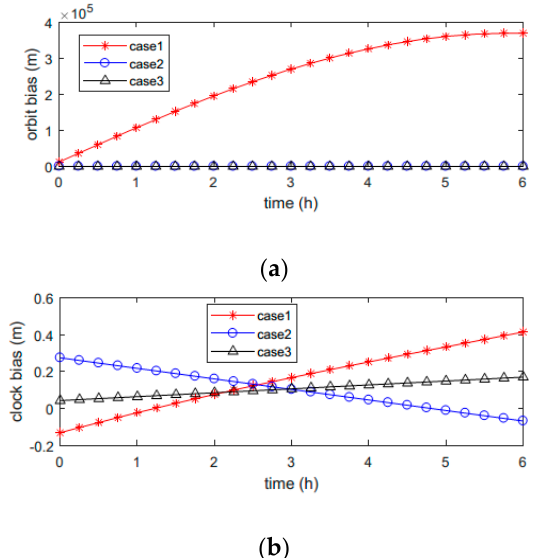
Figure 1. Orbit and clock biases between results calculated with ephemerides before and after the unhealthy state during the satellite unhealthy period. Different cases represent results calculated with different ephemerides. Case 1 represents a maneuvered satellite orbit and clock biases between results calculated with the last healthy broadcast ephemeris before the maneuver and the first healthy one after the maneuver. Case 2 is biases of another satellite without maneuver; parameters are the same as those in case 1. Case 3 represents the maneuvered satellite orbit and clock biases calculated with the last healthy broadcast ephemeris before the unhealthy state and the first unhealthy one after the maneuver began. ( a ) Orbit biases in different cases; ( b ) Clock biases in different cases Lines with different colors and markers represent different cases. Case 1 represents a